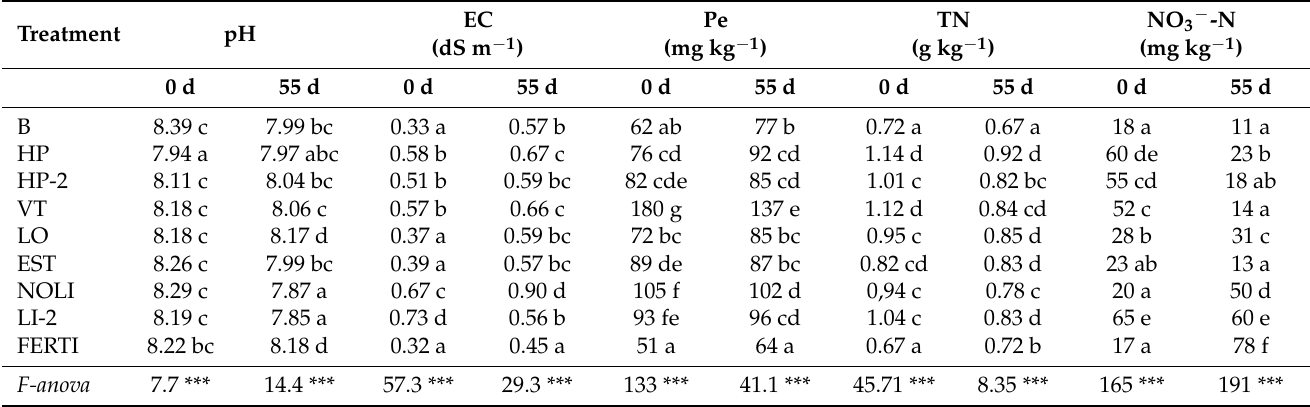
Table 3. Effect of fertilizing treatments on soil